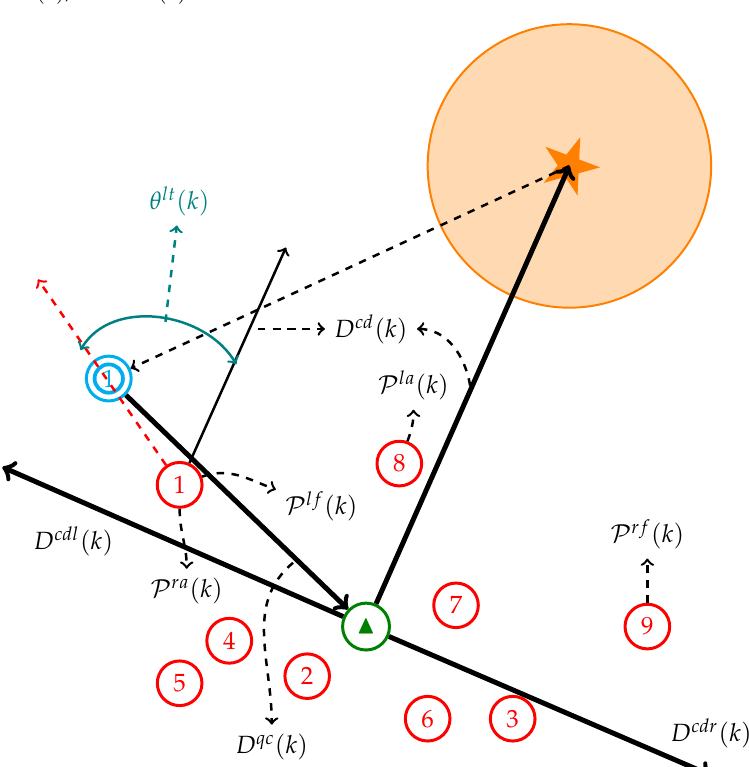
Figure 6. An example illustrating the definitions of D cd ( k ) , D cdl ( k ) , D cdr ( k ) , D qc ( k ) , P la ( k ) , P ra ( k ) , P lf ( k ) , P rf ( k ) , and θ lt ( k )